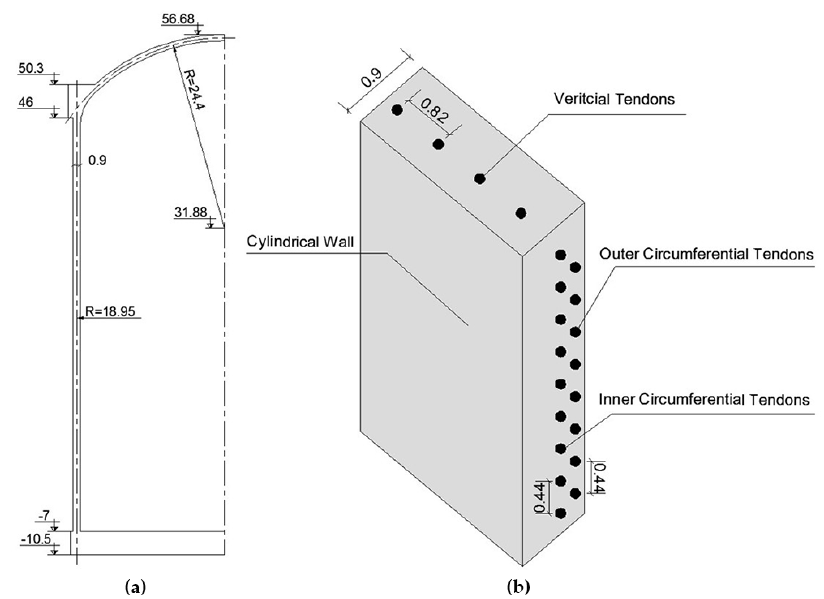
Figure 5. The geometric dimension of PCCV. ( a ) The cross section of PCCV (length unit: m); ( b ) Layout of prestress tendons in cylindrical wall (length unit: m).